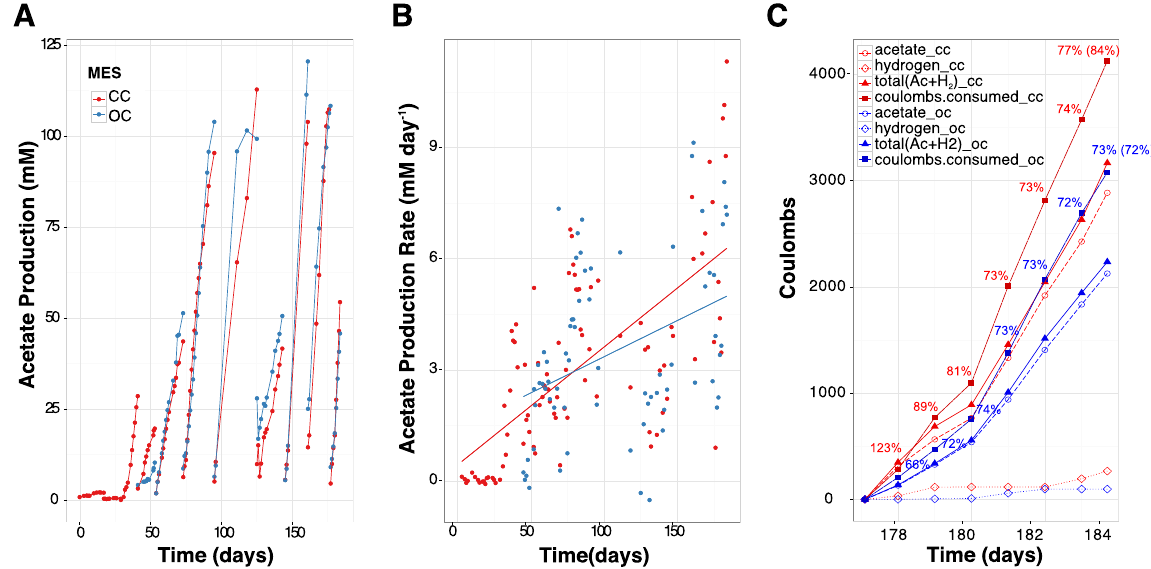
Figure 1. Reactor performance over time. ( A ) Acetate production in CC and OC – breaks in plotted lines indicate an exchange of the medium, ( B ) acetate production rate in CC and OC, and ( C ) accounting of the coulombs over a seven day period between medium exchanges in CC and OC, numbers are percent coulombic efficiency with total percent efficiency averaged over the 7 days in